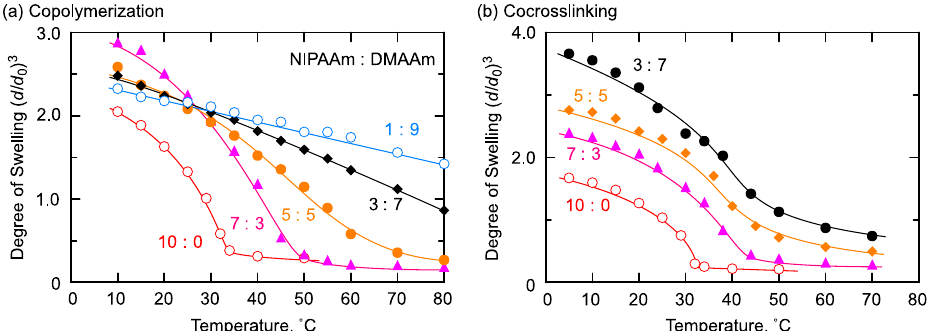
Figure 6. Swelling behavior of NIPAAm/DMAAm ( a ) copolymerization and ( b ) co-crosslinking gels. Preparation condition of copolymerization gels: [NIPAAm] + [DMAAm] = 1400 mM, [BIS] = 48.6 mM, [AIBN] = 55.6 mM in methanol at 55 °C. Preparation condition of co-crosslinking gels: [NIPAAm unit] + [DMAAm unit] = 1400 mM, [NHSA unit] = [amino groups in EDA] in DMF at room temperature.